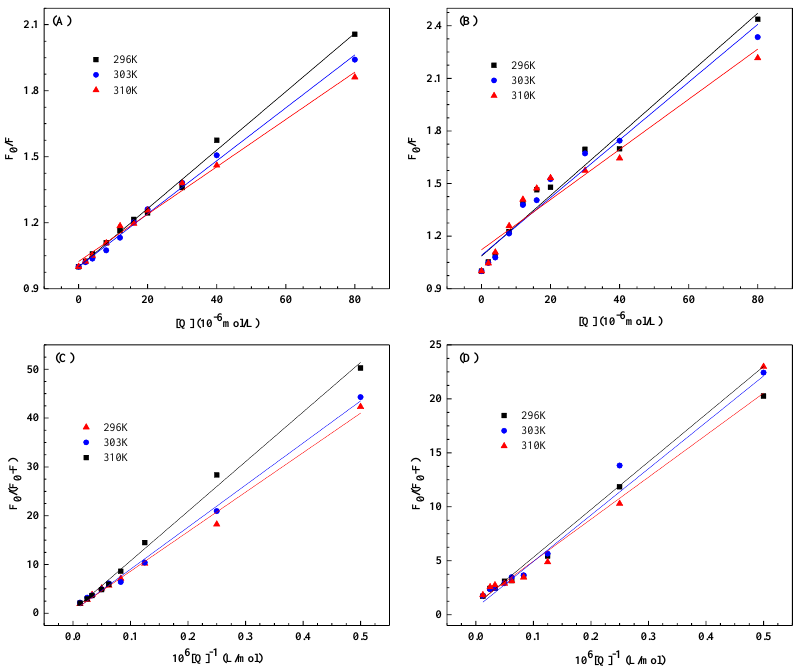
Figure 2. (1) Stern–Volmer plots of the PFOA–HSA ( A ) and PFDA–HSA ( B ) systems at different temperatures; (2) The modified Stern–Volmer plots of the PFOA–HSA ( C ) and PFDA–HSA ( D ) systems at different temperatures. Table 1. Stern–Volmer quenching constants of the PFCA–HSA system at different temperatures.